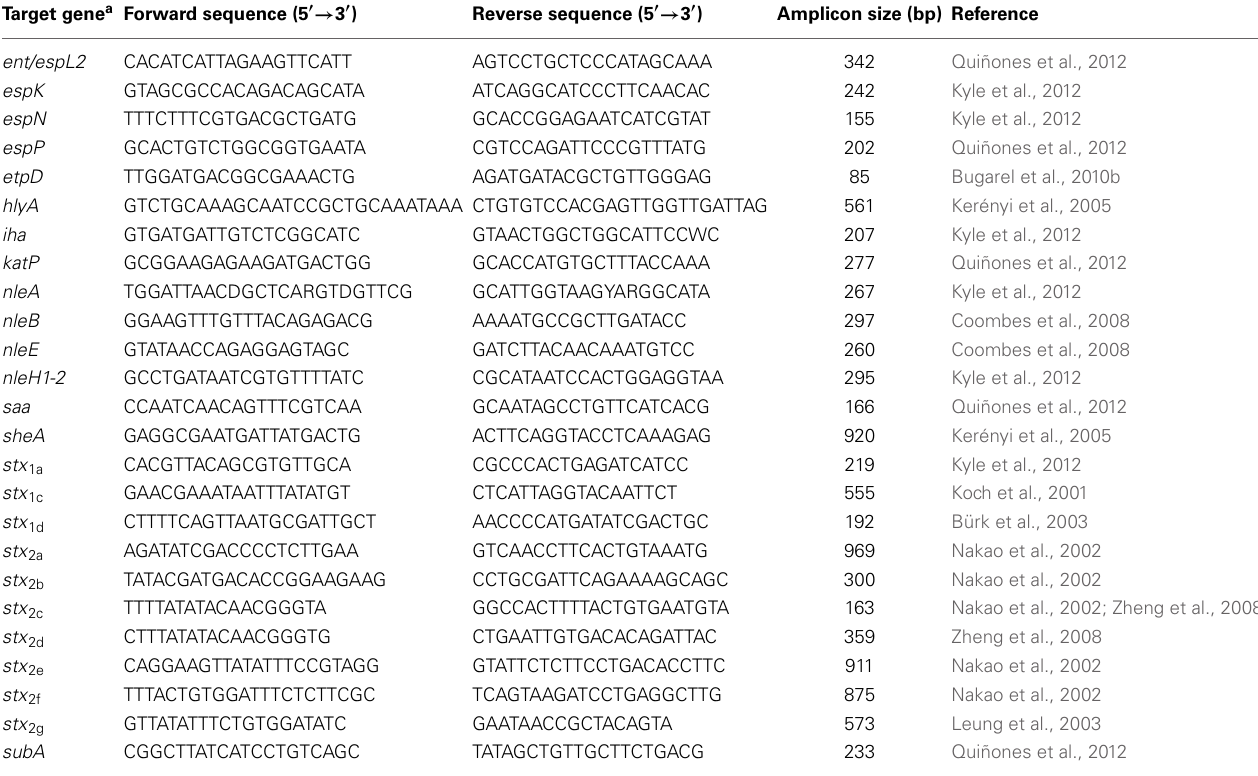
Table 3 | List of DNA oligonucleotides used in this study for PCR amplification. Target gene a Forward sequence (5 (cid:2) → 3 (cid:2) ) Reverse sequence (5 (cid:2) → 3 (cid:2)